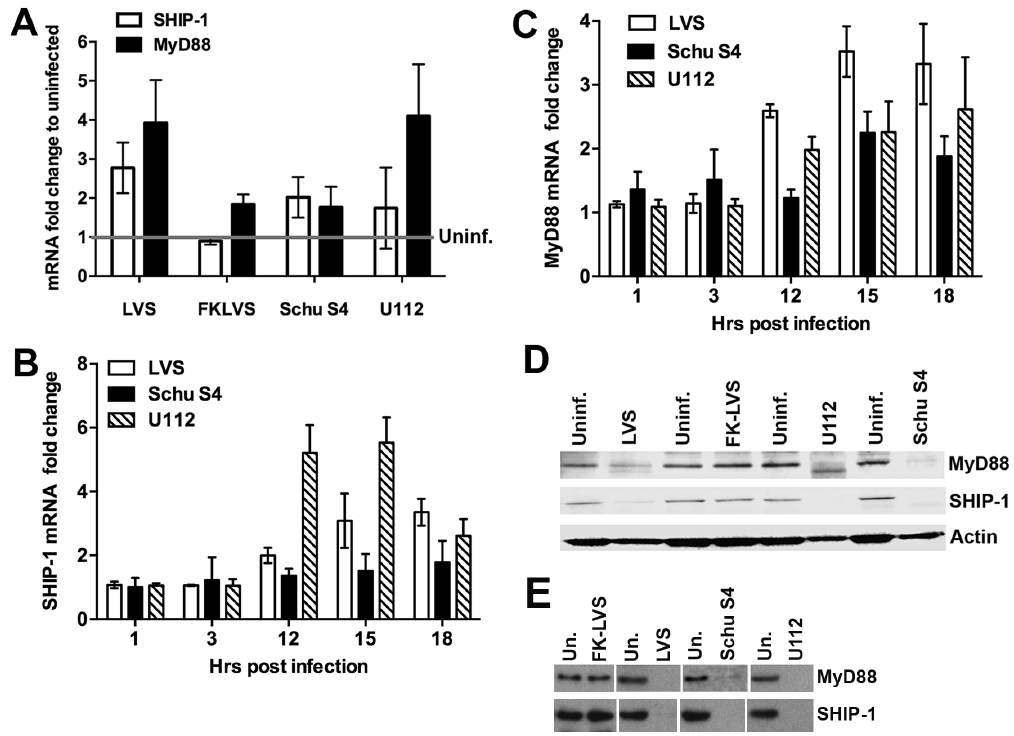
Figure 3. Post- translational depletion of MyD88 and SHIP-1 during Francisella infection. A . MDMs were infected for 18 h with live or formalin-killed (FK) LVS, live Schu S4, or live U112 as indicated, and MyD88 and SHIP-1 mRNAs were measured by qRT-PCR with GAPDH as the internal control. Data shown are the mean 6 SEM (n=3), and were normalized to the uninfected control. B–C . SHIP-1 (C) and MyD88 (D) mRNAs were upregulated in MDMs infected with LVS, Schu S4 or U112. Data shown are the mean 6 SEM (n=3). D . MDMs were left untreated or were infected with live or formalin-killed LVS, live Schu S4 or live U112 for 18 h. Immunoblots of MDM lysates demonstrate disappearance of MyD88 and SHIP-1 protein following infection with live Francisella . Actin was used as the loading control. E . Immunoblots from additional experiments exposed for longer periods of time confirm depletion of MyD88 and SHIP-1. Data in panels D and E are representative of at least three independent determinations.